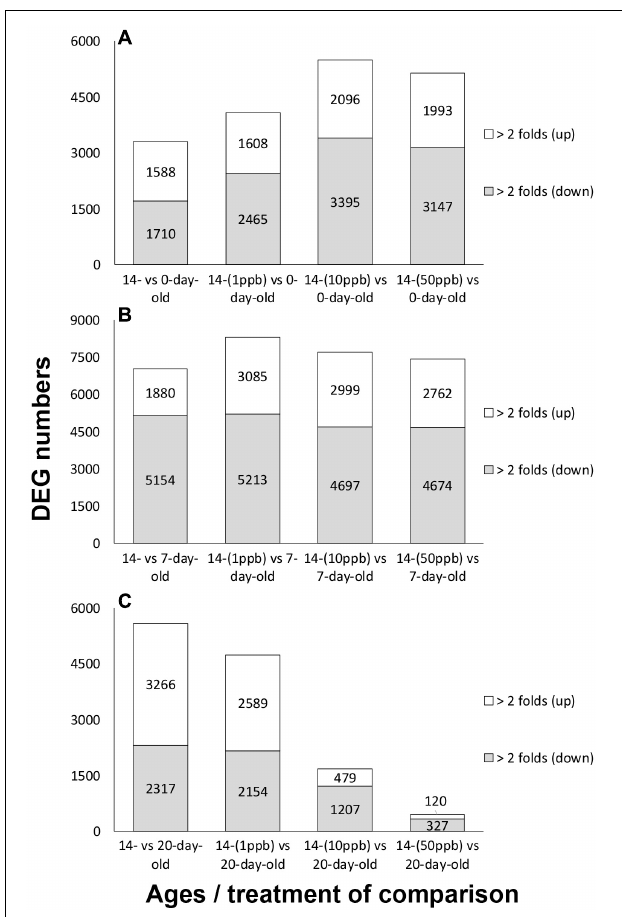
FIGURE 2 | Numbers of differentially expressed genes (DEGs) identified from comparing 14-day-old imidacloprid treated bees with 0-, 7-, and 20-day-old control bees. (A) Fourteen-day-old imidacloprid treatments compared to 0-day-old adult control. (B) Fourteen-day-old imidacloprid treatments compared to 7-day-old adult control. (C) Fourteen-day-old imidacloprid treatments compared to 20-day-old adult control. DEGs were subdivided based on regulatory trends. Twofold (up): DEGs with a log 2 fold change ≥ 1; twofold (down): DEGs with a log 2 fold change ≤ –1. Numbers of DEGs are shown in each